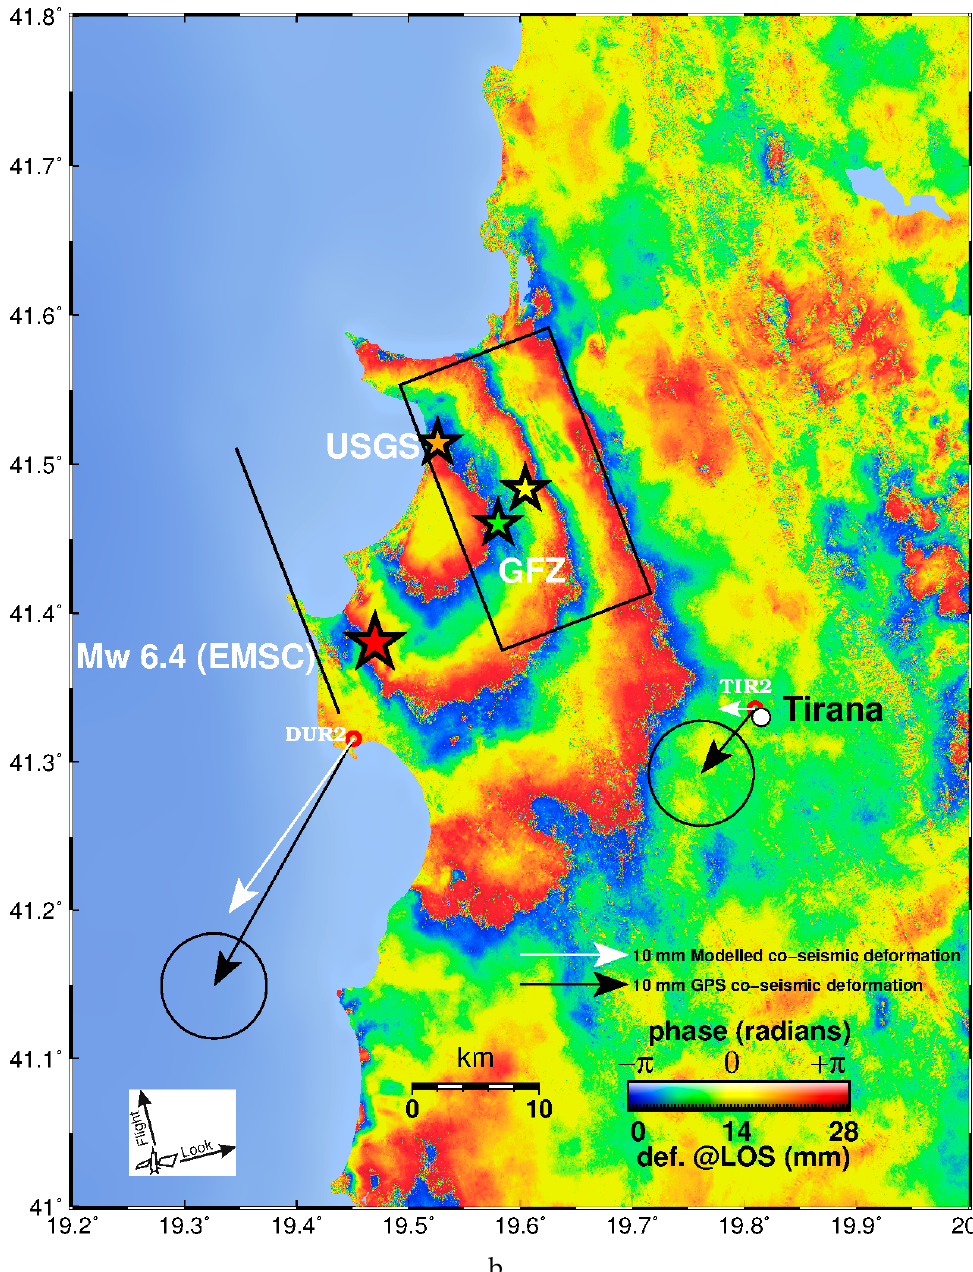
Figure 2. ( a ) . Sentinel-1 wrapped interferogram descending track 153 (acquisition dates 20191125-20191201). Yellow star indicates the location of the geodetic centroid (this study). Black rectangle shows the surface projection of the seismic fault. Solid black line indicates fault plane intersection to the Earth’s surface. The red star indicates the earthquake epicentre (EMSC location), orange and green stars USGS and German Research Centre for Geosciences (GFZ) epicentres, respectively. The vector pairs represent the GPS measured (black) and modelled (white) co-seismic horizontal displacements at stations DUR2 and TIR2 respectively (see Table 3 for values). ( b ). Sentinel 1A wrapped interferogram ascending track 175 (acquisition dates 20,191,120 and 20,191,126 16:32 UTC). Yellow star indicates the location of the geodetic centroid (this study). Black rectangle shows the surface projection of the seismic fault. Solid black line indicates fault plane intersection to the Earth’s surface. The red star indicates the earthquake epicentre (EMSC location). The vector pairs represent the Global Positioning System (GPS) measured (black) and modelled (white) coseismic horizontal displacements at stations DUR2 and TIR2 respectively (see Table